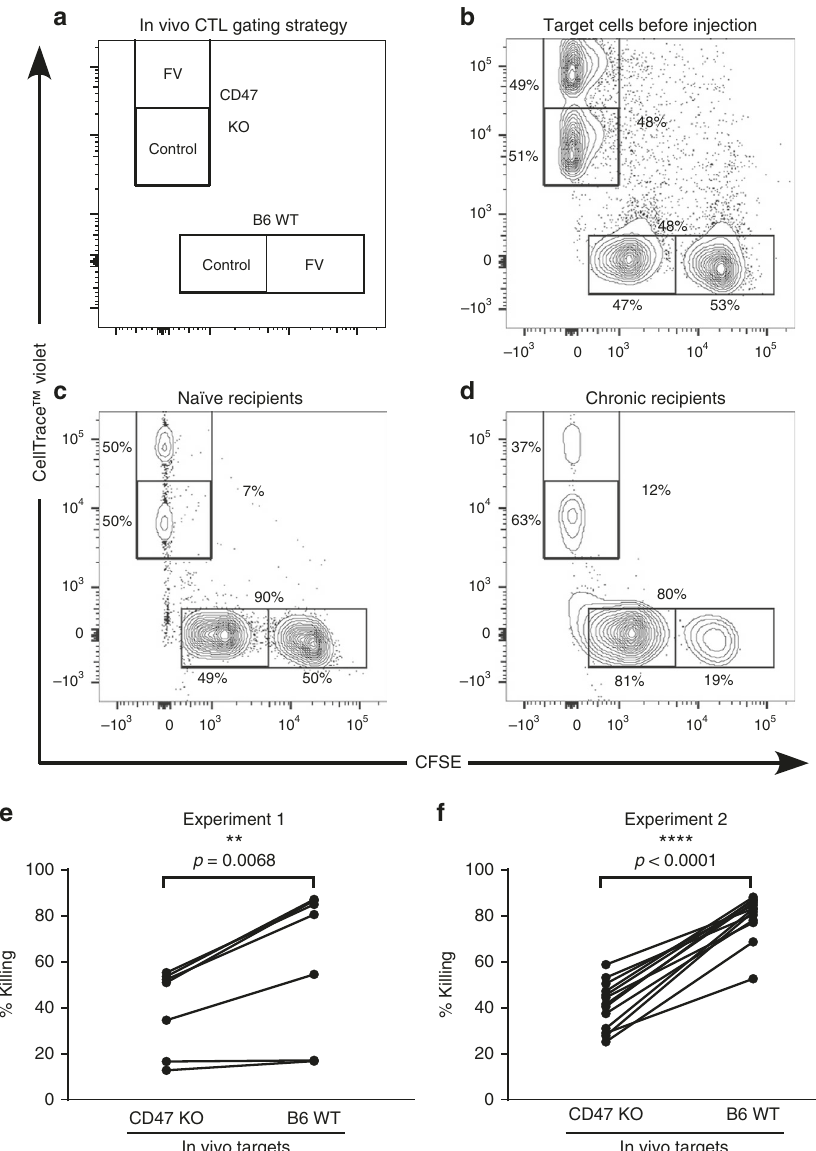
Fig. 6 Enhanced in vivo cytolytic activity against target cells expressing CD47, the ligand for signal-regulatory protein alpha. Naive and mice chronically infected with Friend virus (FV) were adoptively transferred with differentially fl uorophore-labeled target cells as outlined in a and in Methods. Brie fl y, wild- type C57/BL6 splenocytes were differentially labeled with two concentrations of carboxy fl uorescein succinimidyl ester and CD47 − / − splenocytes were differentially labeled with two concentrations of CellTrace TM -violet. The brighter of each subset was peptide-loaded with 25 μ M FV-D b GagL peptide, while the lower intensity subset was sham-loaded in dimethyl sulfoxide media. a The gating strategy identifying the target cell populations and representative dot plots showing target cell populations (b) before injection and retrieved from ( c) naive and ( d) chronic recipients 6 h post-transfer. The percentages given are the means for each cell subset combining data from two independent experiments. e , f The percentage of killing comparing C57/BL6 WT and CD47 − / − target cells as described in Methods. The data points showing the killing of each type of target cell within the same recipient mouse were connected with a line and the differences were statistically signi fi cant as indicated by two-way paired t tests. Data from the two independent